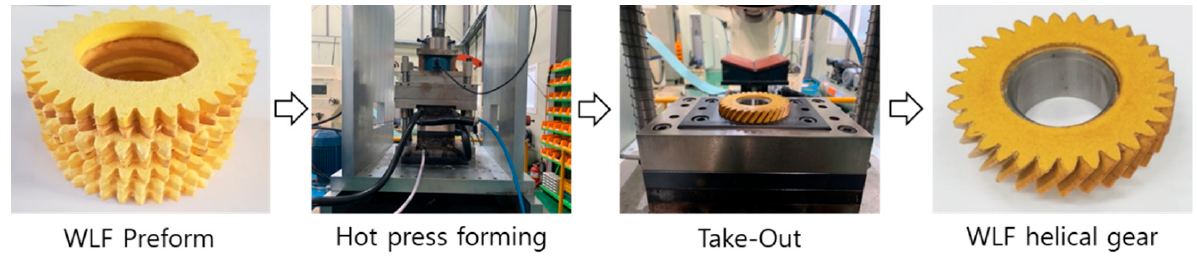
Figure 13. Fabrication of the WLF helical gear. Table 6. Molding conditions of the WLF helical gear. Hot press die temperature 160 ◦ C Press load of the Punch die 10 ton